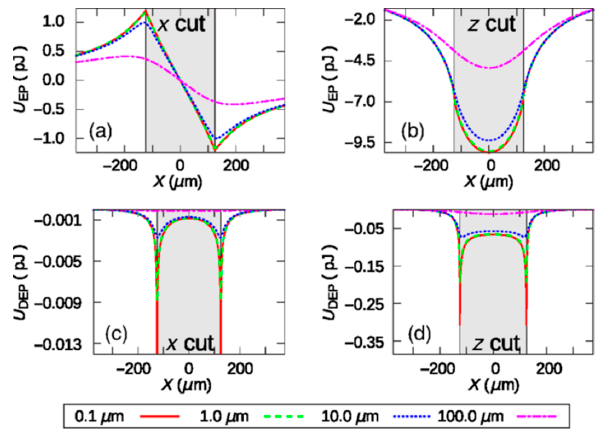
Figure 3. EP ( a , b ) and DEP ( c , d ) potentials due to a single square illumination in x ‑ cut ( a , c ) and z ‑ cut ( b , d ). Potentials are calculated at the central plane of the square, perpendicular to the crystal and